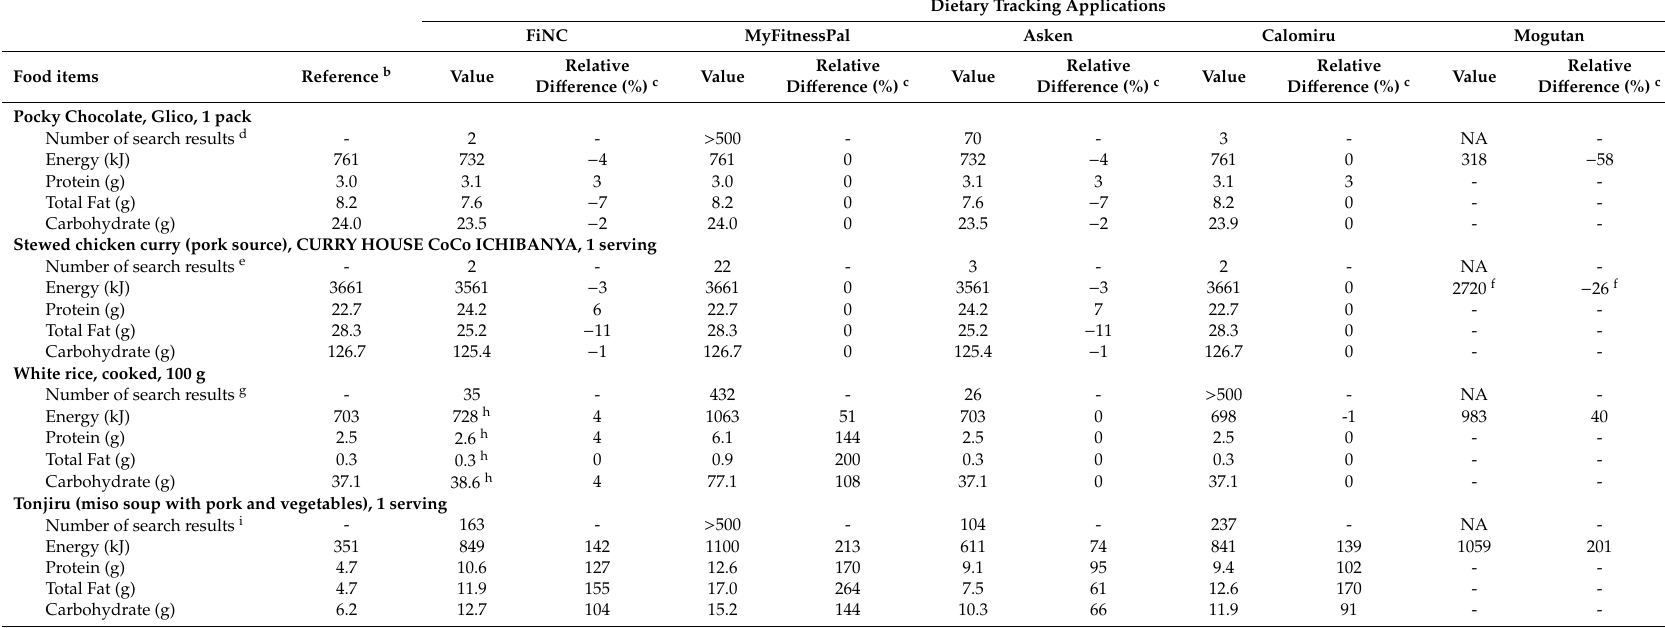
Table 4. Examples of energy and nutrient contents in the diet-tracking applications for four food items a